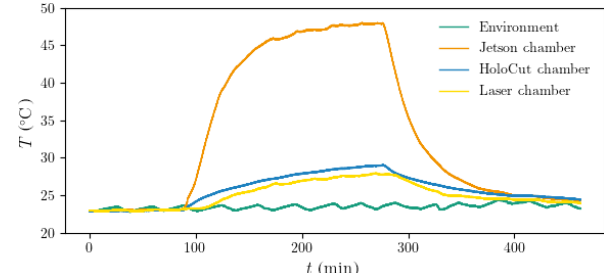
Figure 7. Temperature curve of HoloPort at 23 ◦ C ambient temper- ature: the isolation of the laser chamber from the Jetson chamber fulfills its purpose and leads to 20 ◦ C less